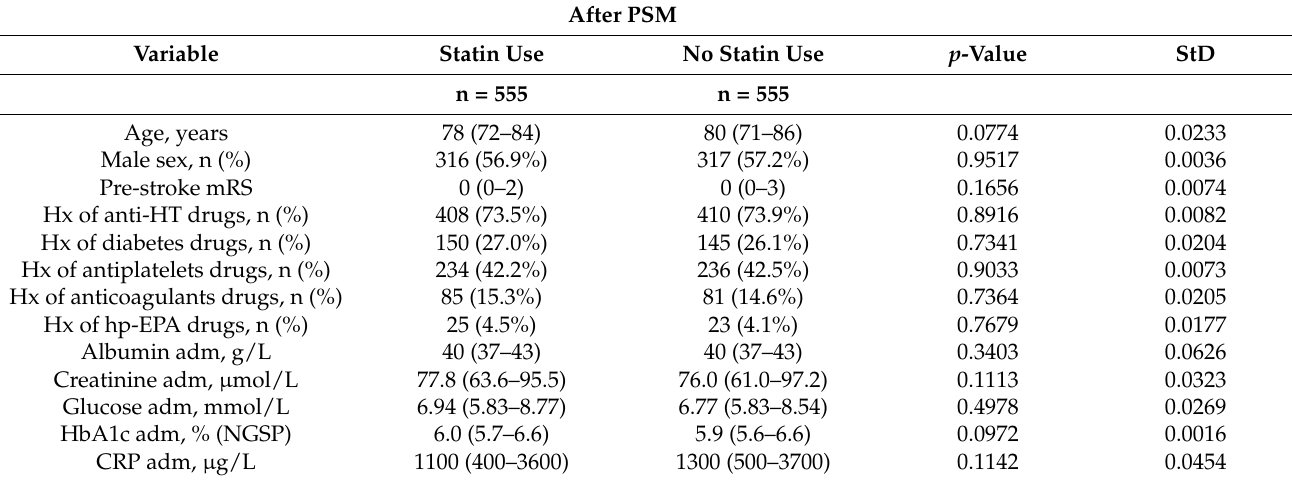
Table 2. Comparison of variables between the matched pairs after propensity score matching (n = 1110).